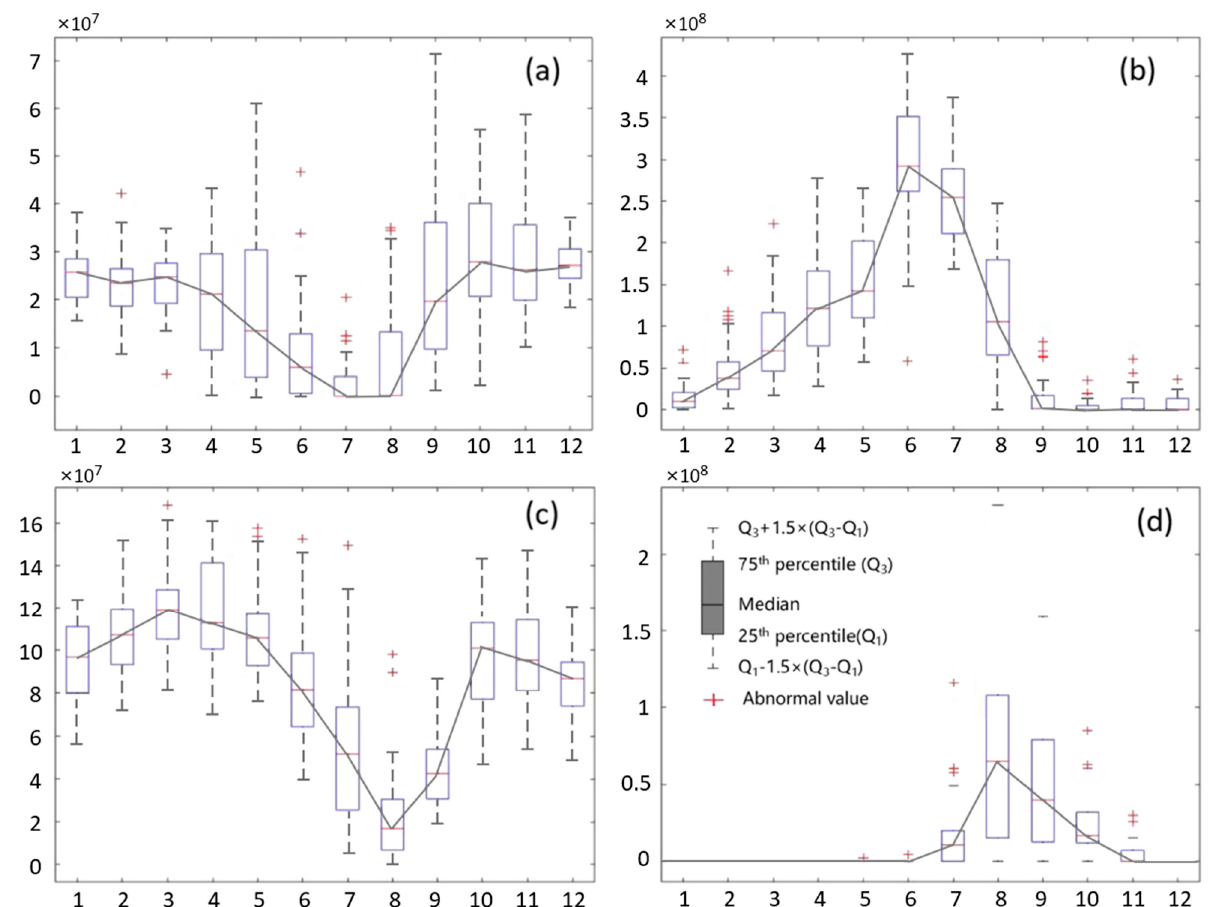
Figure 5. Total monthly water vapor input from each boundary year in the middle and lower reaches of Yangtze River (1981–2015) ( a ) north boundary ( b ) south boundary ( c ) west boundary ( d ) east boundary.